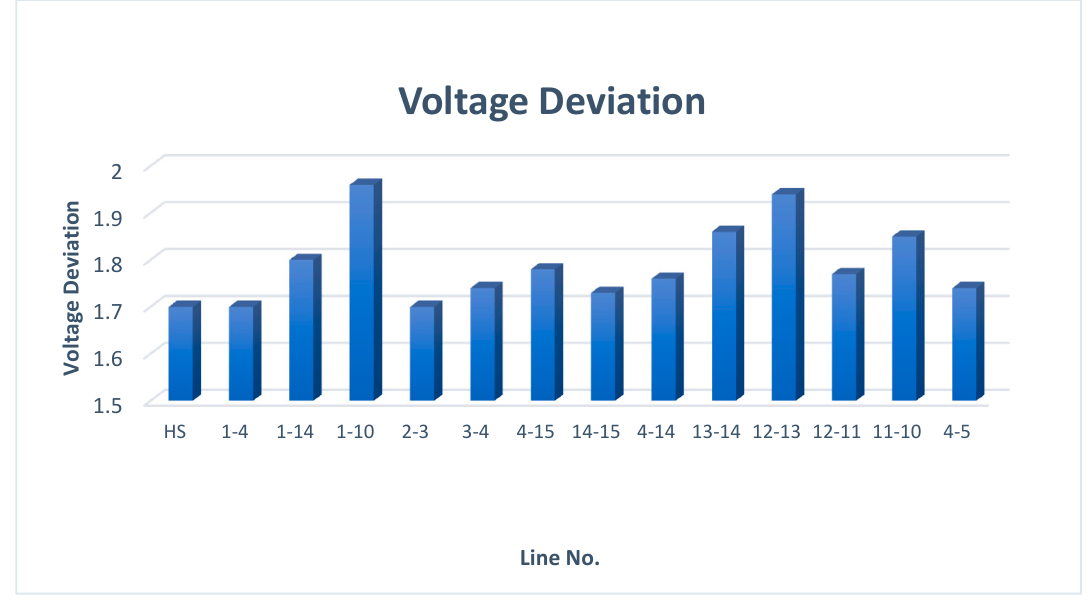
Figure 7. Voltage Deviation of Indian 62 Bus system for various contingencies. HS = Healthy System.